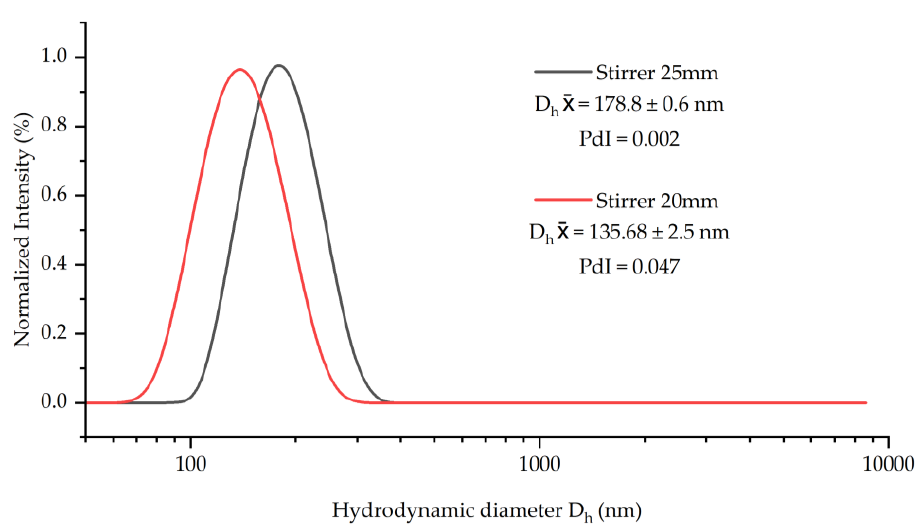
Figure A1. Hydrodynamic average diameter of particles measured via dynamic light scattering (DLS) using two different stirrer sizes. The different samples were fabricated with two sizes of stirrers, 20 and 25 mm. The vortex created by the stirrers resulted consistently in different particles sizes, although all the other conditions were carefully maintained constant.